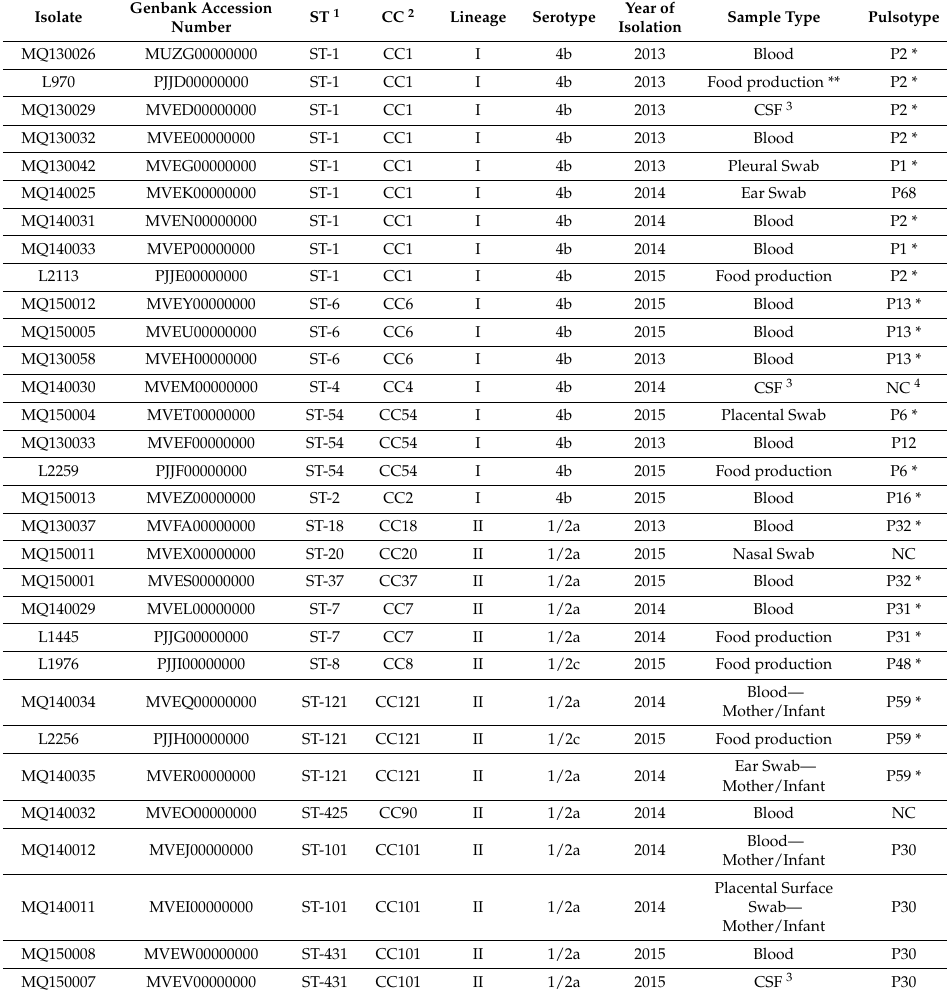
Table 1. Listeria monocytogenes strains sequenced in this